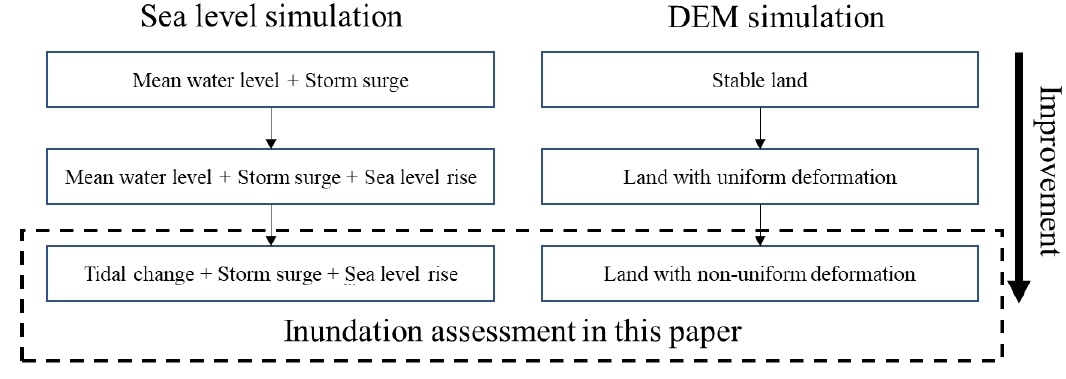
Figure 34. Inundation assessment in this paper.